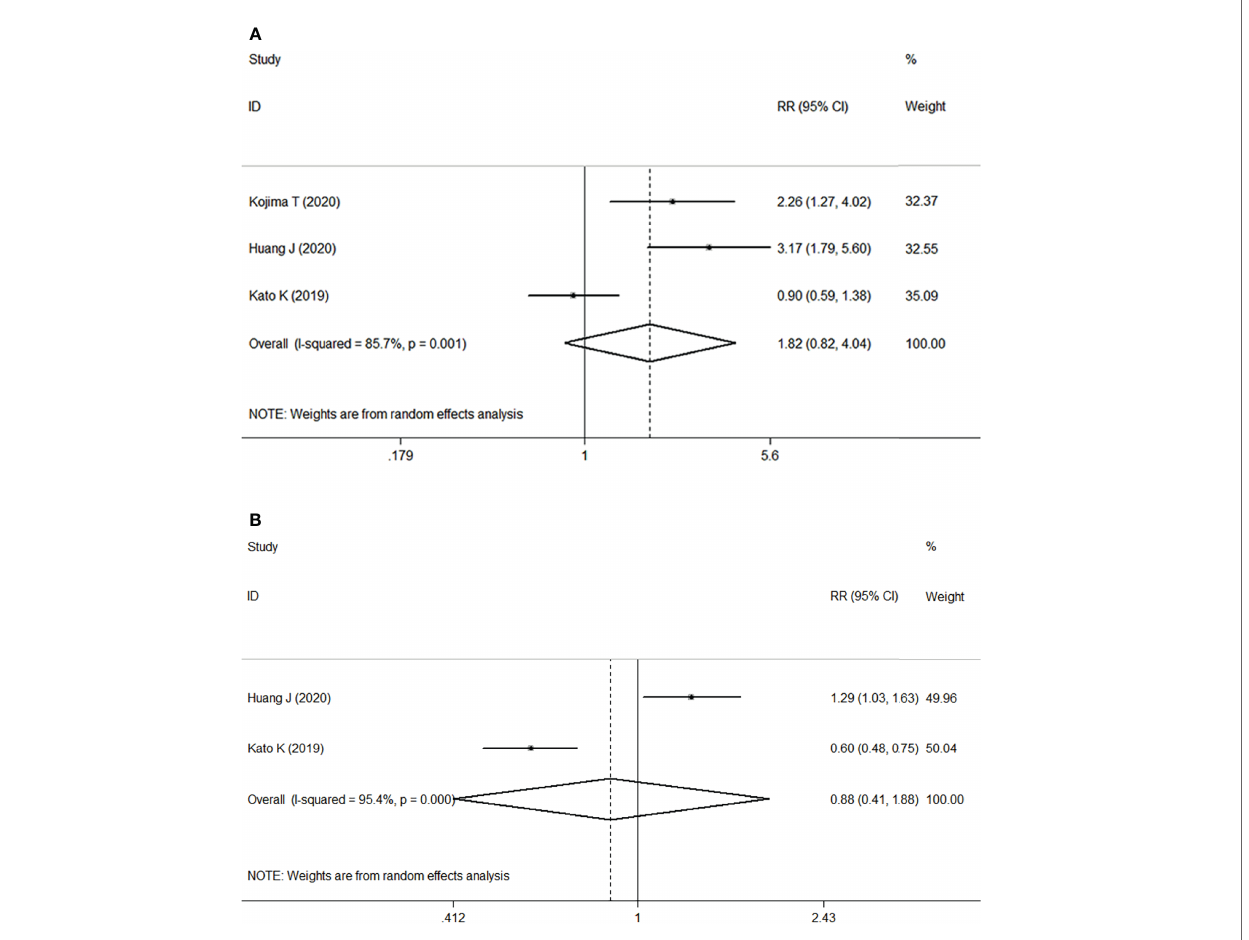
FIGURE 2 | Forest plots. (A) Forest plots of RR comparing the objective response rate between patients treated with ICI and chemotherapy; (B) Forest plots of RR comparing disease control rate between patients treated with ICI and chemotherapy. RR, relative risk; CI, con fi dence interval; ICI, immune checkpoint